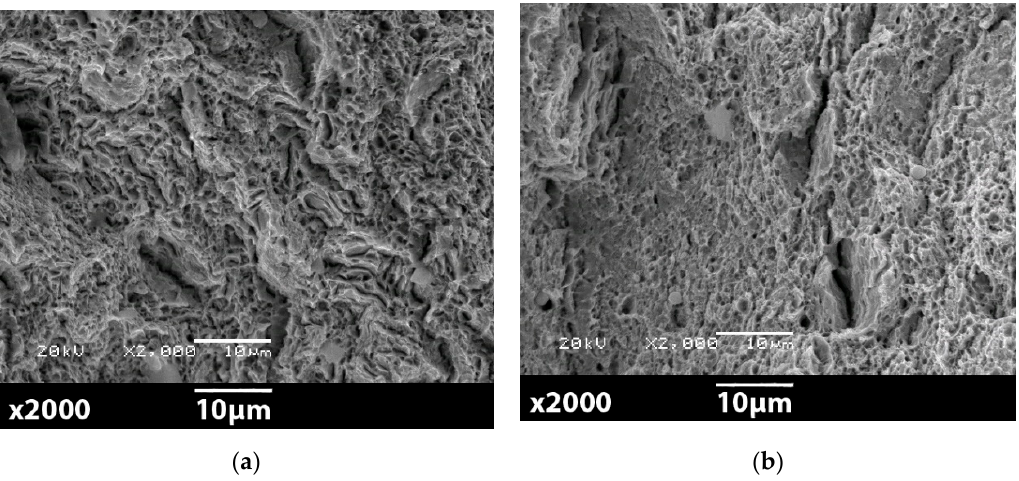
Figure 33. Fracture of 41Cr4 (HT), 35 HRC: ( a ) on the notch-edge; and ( b ) in central area of sample.